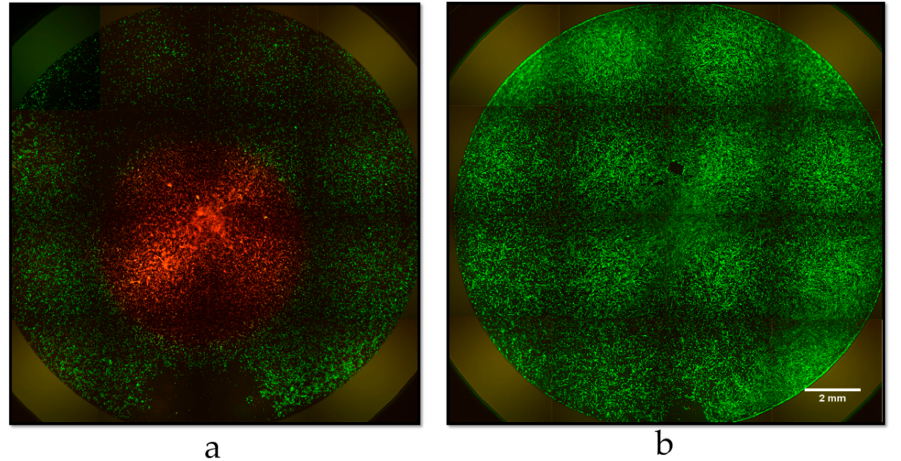
Figure 7. Fluorescence microscopy images of U-118 MG cells incubated with NDs@PDA@ICG ( a ) with and ( b ) without NIR laser irradiation by LIVE/DEAD assay. Alive cells are shown in green, whereas dead cells are shown in red.